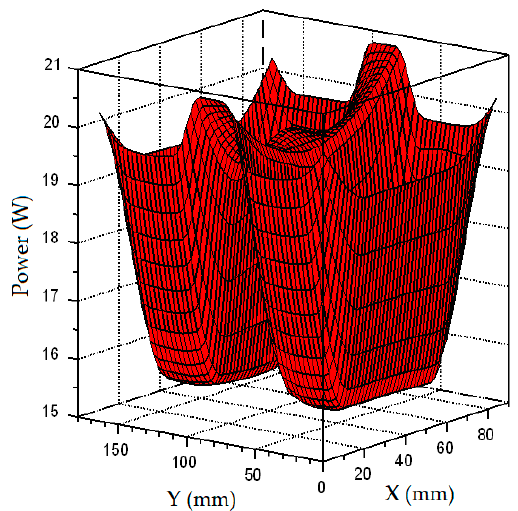
Figure 9. The 3D plot of the transmitted power as a function of the relative position of the receiver.